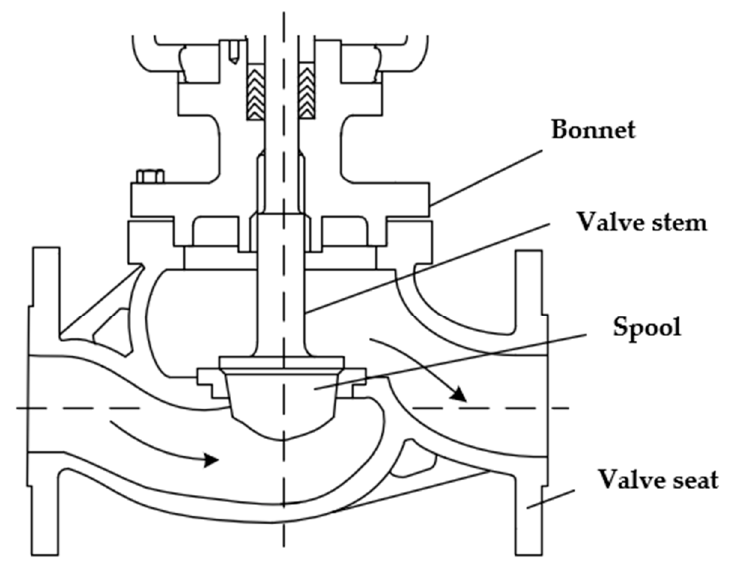
Figure 4. Structural diagram of the control valve